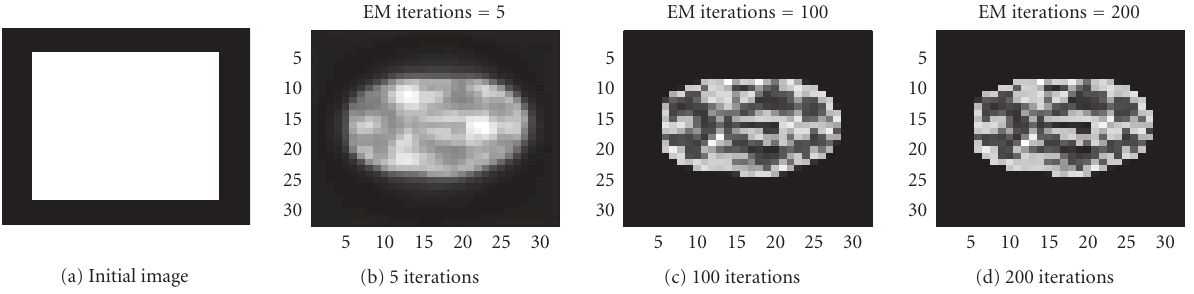
Figure 7: Evolution of a brain image with the EM algorithm.